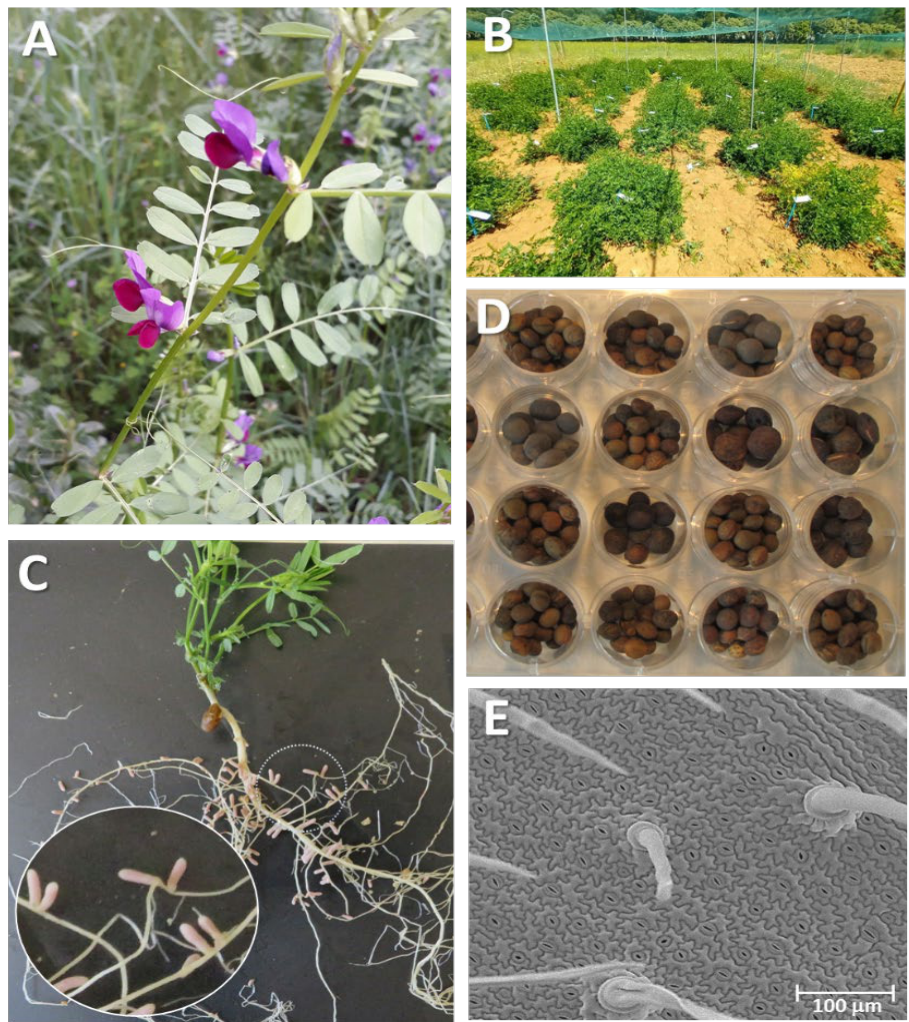
Figure 3. V. sativa plants showing different tissues and growing stages. ( A ) Wild-growing common vetch at “Sierra Norte”-Madrid (Spain). ( B ) Field evaluation assay of different accessions (CRF- INIA/CSIC gene bank). ( C ) Indeterminate Rhizobium nodules of a common vetch root. ( D ) Diversity of size, shape, and color observed in seeds from different accessions from a CRF core collection. ( E ) Abaxial leaf surface, showing trichomes, stomas, and epidermal cells.